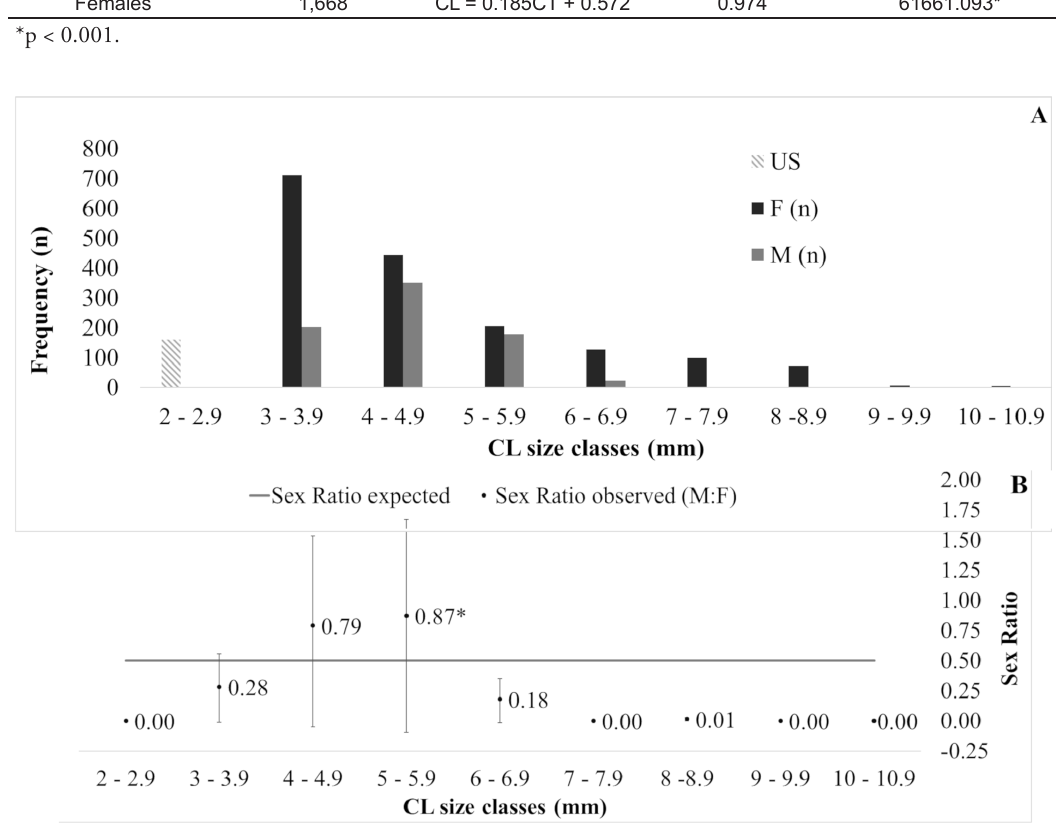
Figure 2. Frequency of individuals and sex ratio by size class in a population of Macrobrachium amazonicum in Miranda dam (MG) between april/2012 and may/2013. A: frequency distribution of males and females in Carapace Length size (US – undetermined sex; M – Male; F – Female). B: sex ratio by size class. *not significant difference.